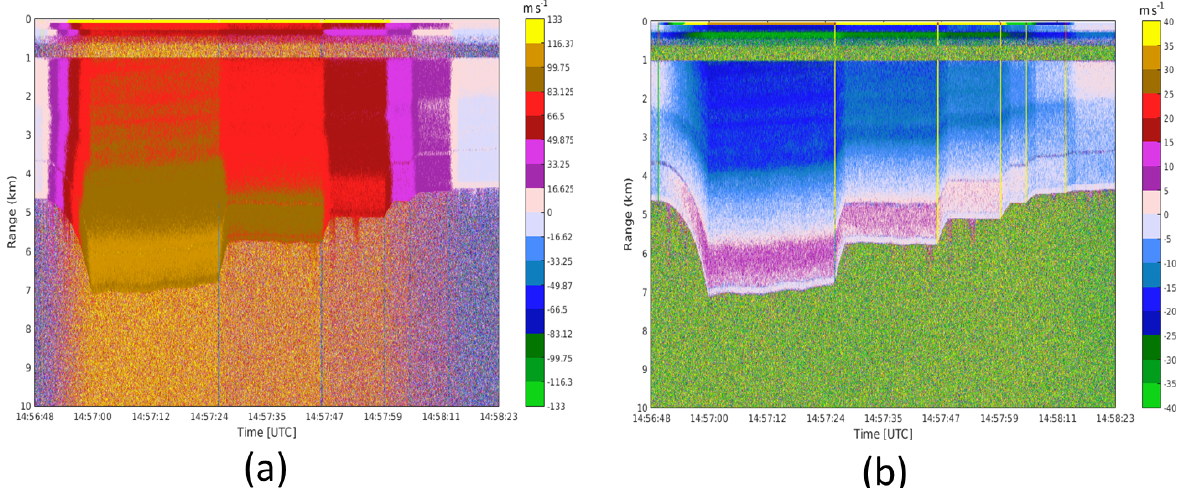
Figure 16. Velocity fields for the case study in Fig. 15: (a) measured PDPP velocity and (b) estimated velocity of the precipitation along the direction of the antenna beam based on PDPP measurements and after removal of aircraft